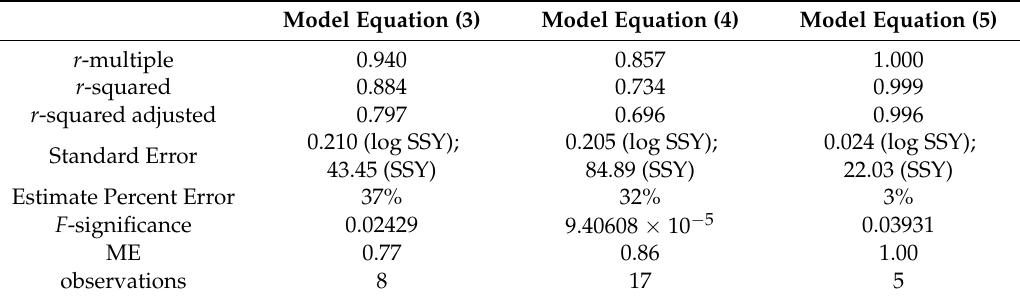
Table 4. ANOVA of regression model (3) and (4).